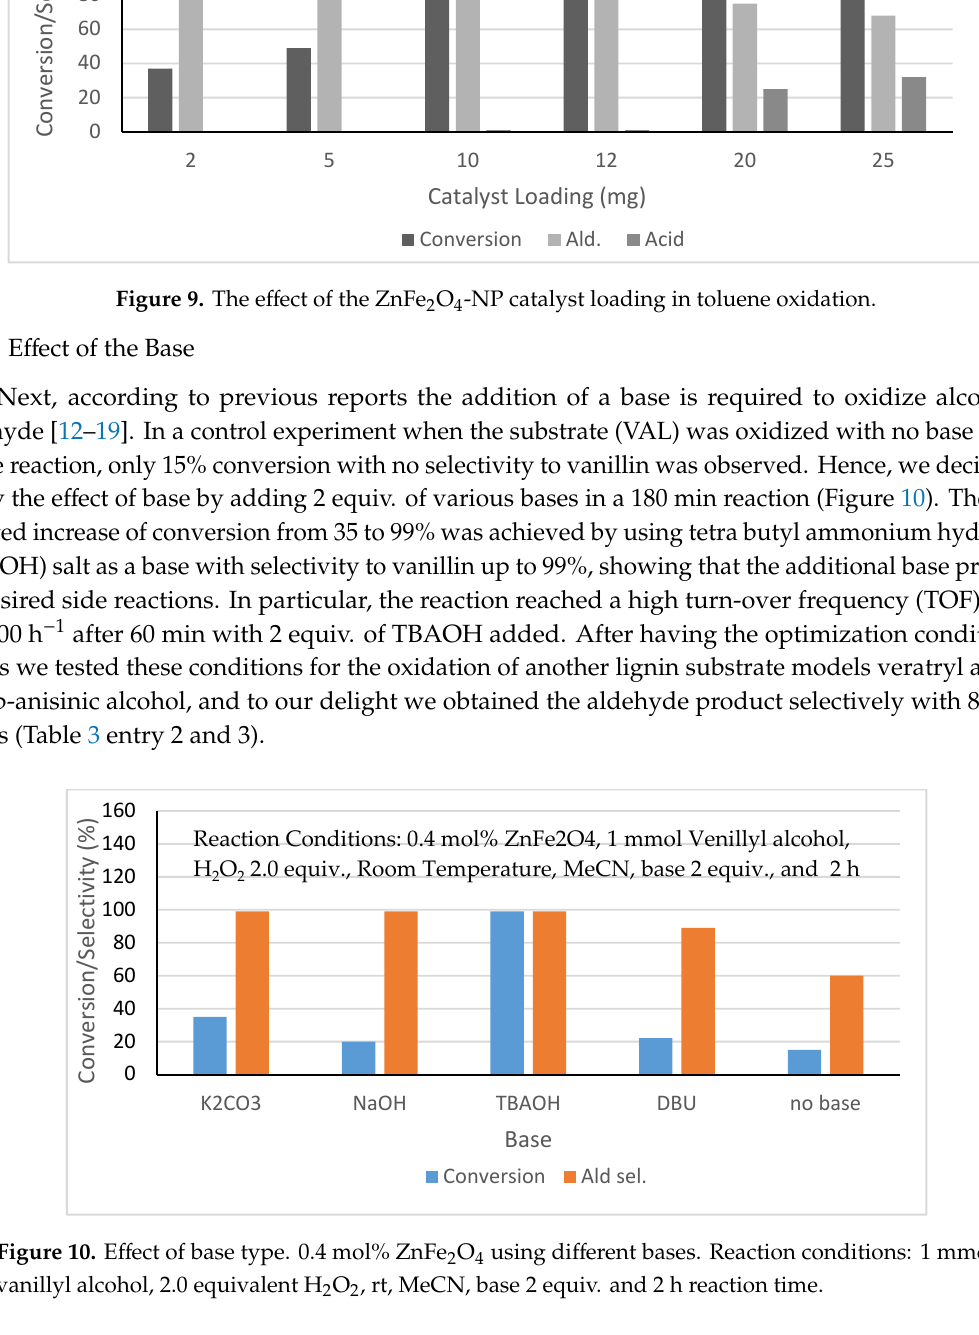
Figure 10. Effect of base type. 0.4 mol% ZnFe 2 O 4 using different bases. Reaction conditions: 1 mmol vanillyl alcohol, 2.0 equivalent H 2 O 2 , rt, MeCN, base 2 equiv. and 2 h reaction time.